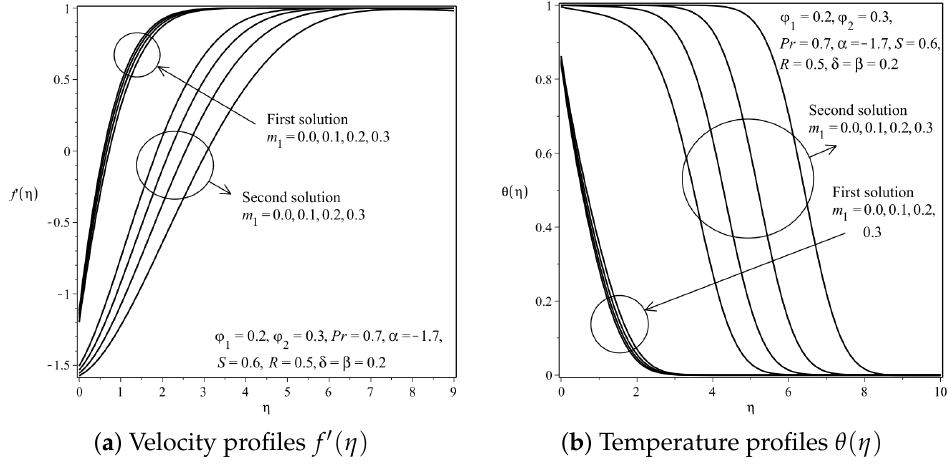
Figure 6. The flow of f (cid:48) ( η ) and θ ( η ) against m 1 .